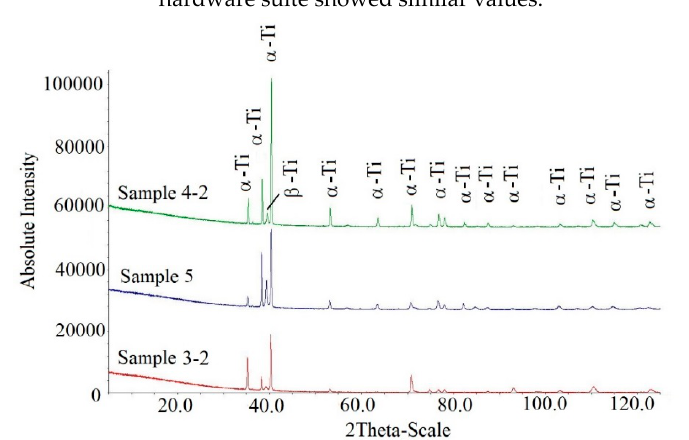
Figure 7. X-ray patterns of details No. 3 (sample No. 3–2); No. 4 (sample No. 4–2) and No. 5 (deposited section of the sample).